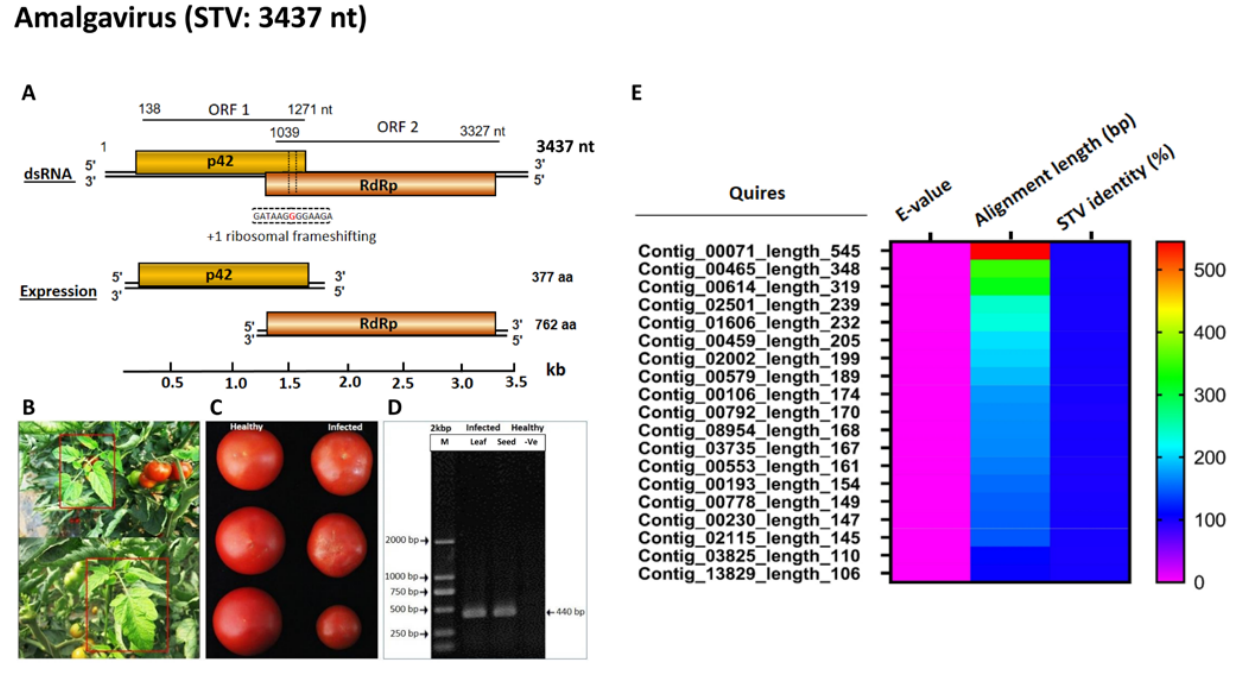
Figure 1. The genomic organization and detection of STV through reverse transcription–polymerase chain reaction (RT-PCR) from infected tomato leaf and seed samples. ( A ) Schematic representation of the genome organization and translation of STV, including the UTR regions and gene distribution. The nucleotide positions of open reading frames (ORFs) were exemplified using the STV Pk isolate (MT066231). ( B ) Infected plants displaying typical chlorotic, leaf yellowing (shown in red boxes), stunting, and fruit malformation. ( C ) Tomato fruit with discoloration and size reduction alongside fruit from healthy tomato plants. ( D ) Agarose gel electrophoresis of RT-PCR products indicating amplified STV fragments that covered a conserved region of p42 and RdRp at the position of ribosomal frameshifting from infected tomato leaf and seed samples compared with a healthy sample. ( E ) Heatmap columns representing different parameters (E-value, alignment length, and percentage identity) associated with contigs mapped to the STV genome. Pink and red colors denote the lowest and highest values, respectively.